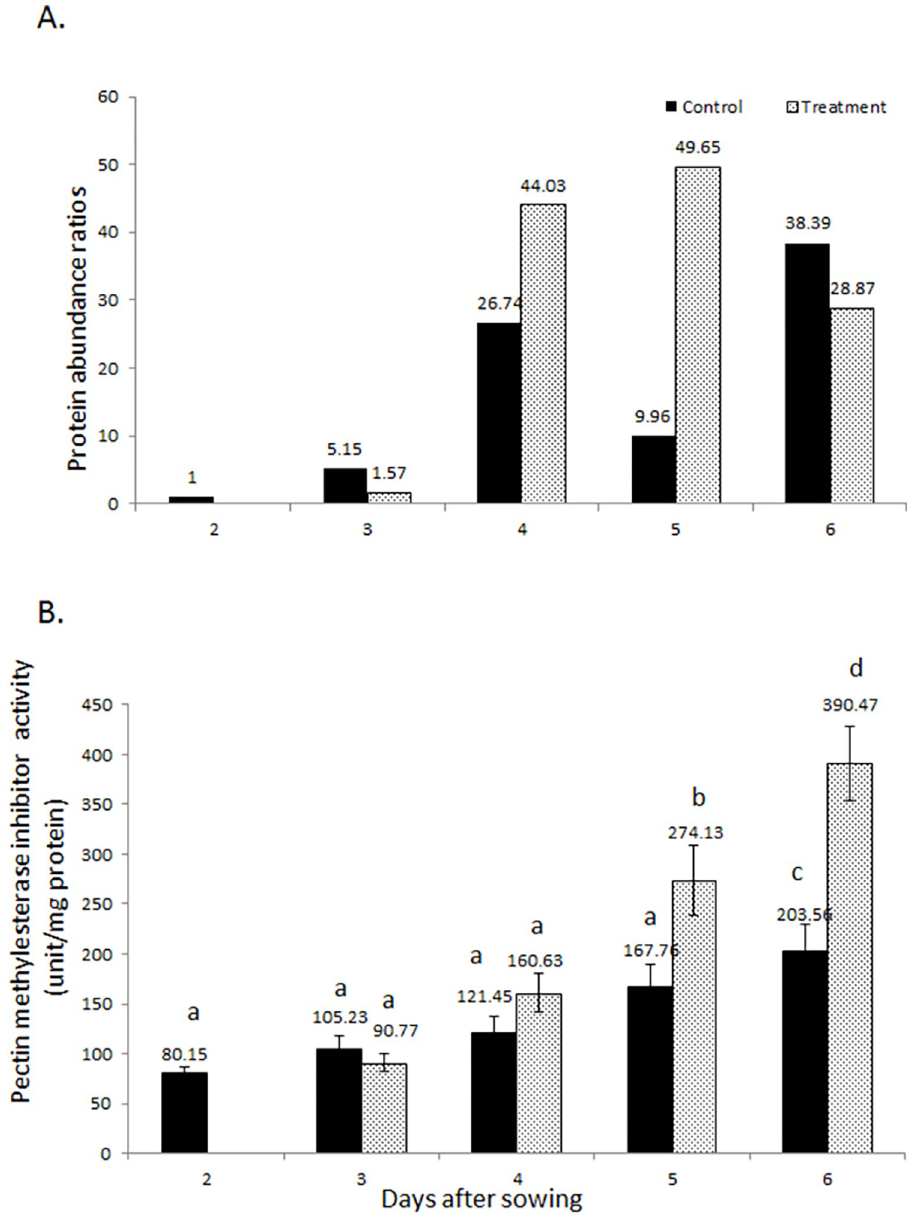
Fig 7. Changes in protein abundance (A) and enzyme activity (B) of plant invertase/pectin methylesterase inhibitor in soybean roots under flooding stress. Different alphabets indicate significant changes as determined through One-way ANOVA and Duncan’s multiple range